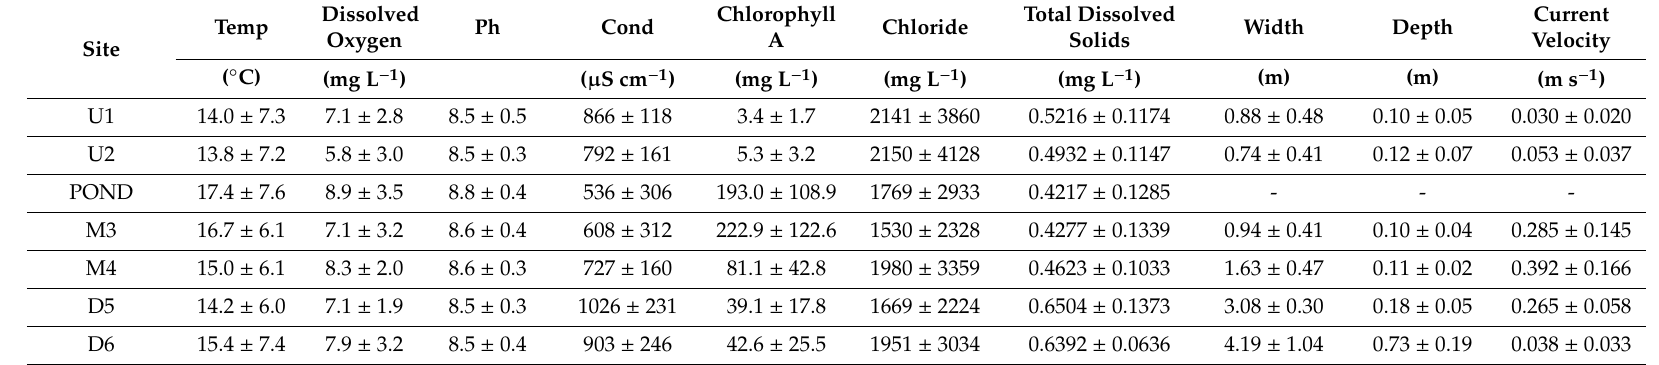
Table 1. Mean ± SD of environmental variables at the examined sites in the Buk ó wka stream. Temp—temperature;